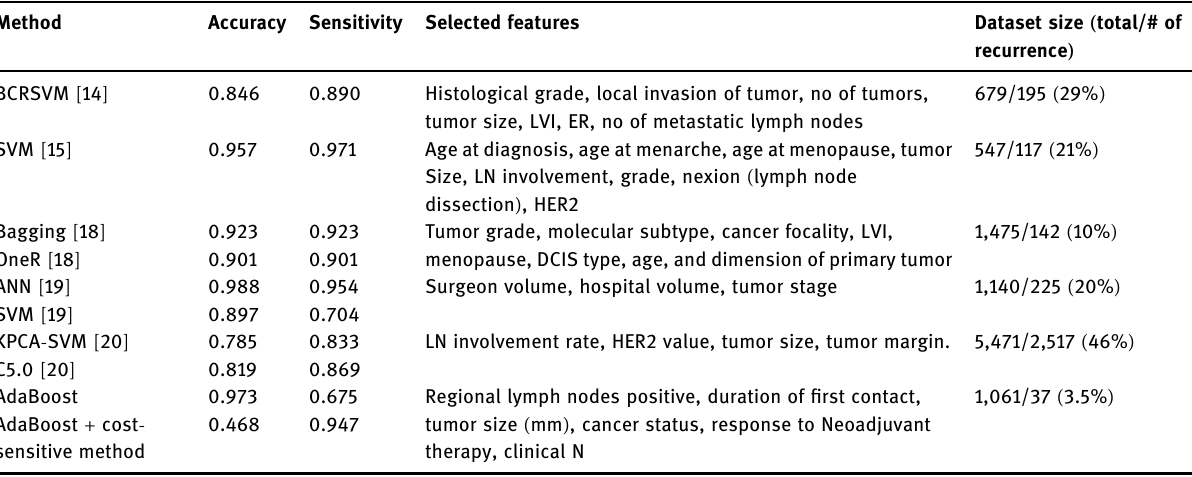
Table 7: Performance comparison of breast cancer recurrence prediction model Method Accuracy Sensitivity Selected